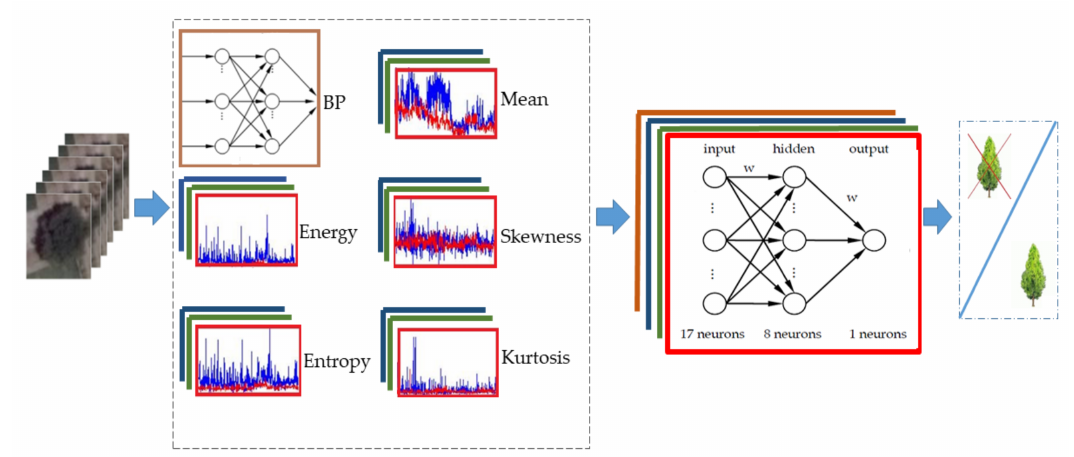
Figure 6. 3–3-layer cascade-neural-network model.